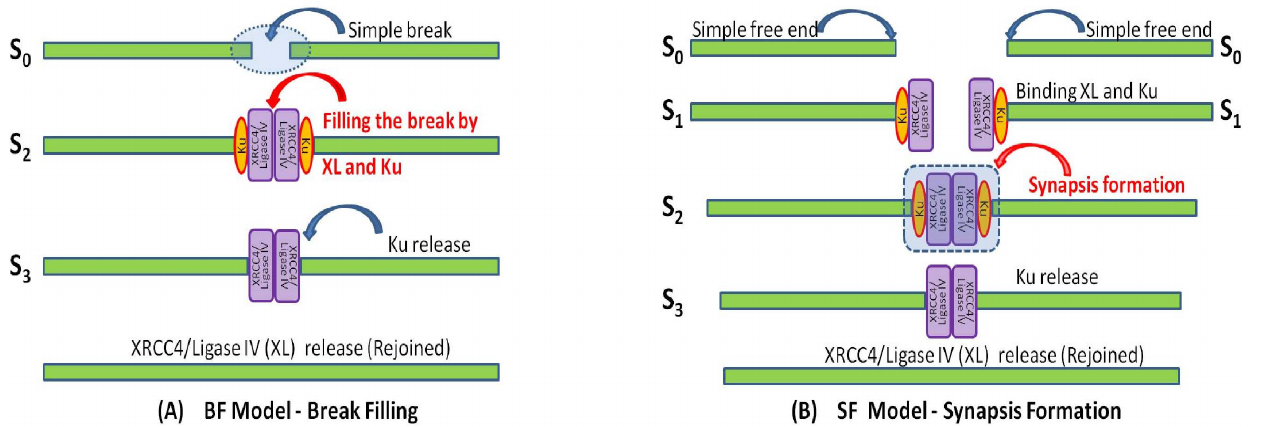
Figure 1. Modeling the repair of simple DNA double strand breaks. DSBs repair can be modeled in terms of either (A) Break filling in which the break between two nearby DNA ends remains and is filled by NHEJ proteins for ligation and repair. S 0 represents the simple break, S 2 the break filled by Ku and XRCC4/Ligase IV (XL) and S 3 the filled break with Ku released. (B) Synapsis formation in which the break may become a larger gap due to diffusion and requires the extra roles of NHEJ protein to tether and rejoin the DNA ends, and S 0 represent the simple free DNA end, S 1 simple DNA end bound with Ku and XL, S 2 the synapsis fromed by two simple DNA ends and S 3 the synapsis with Ku released.